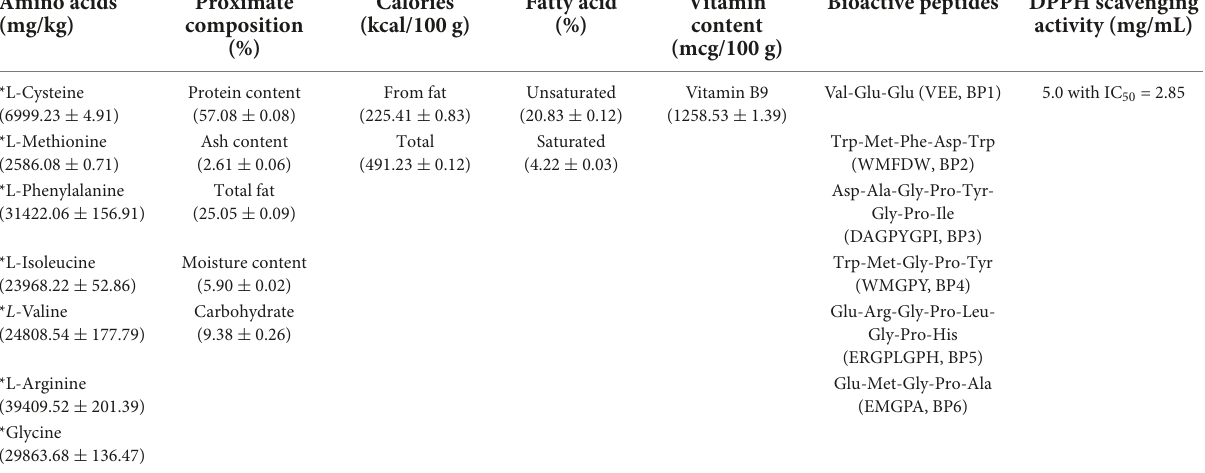
TABLE 3 Nutrient composition, amino acids, bioactive peptides, and antioxidant scavenging activity of CEST. Amino acids